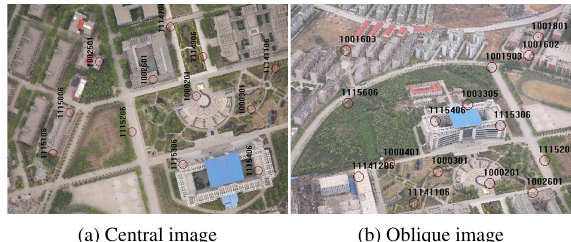
Figure 6. The aerial images used in this experiment. The red circles in the images are control points measured by GPS-RTK. (Figure 6a has been rotated for better visualization): (a) Image 1: captured by central camera of SWDC, and (b) Image 2: cap- Figure 8. Aerial images for real image orientation experiment. tured by an oblique camera of SWDC. Red circles are correct correspondences, whose 3D control points Table 2. The Experimental Results of the First Image Table 2. The Experimental Results of the First Image Methods are measured by GPS-RTK technique and 2D image points are Methods manually